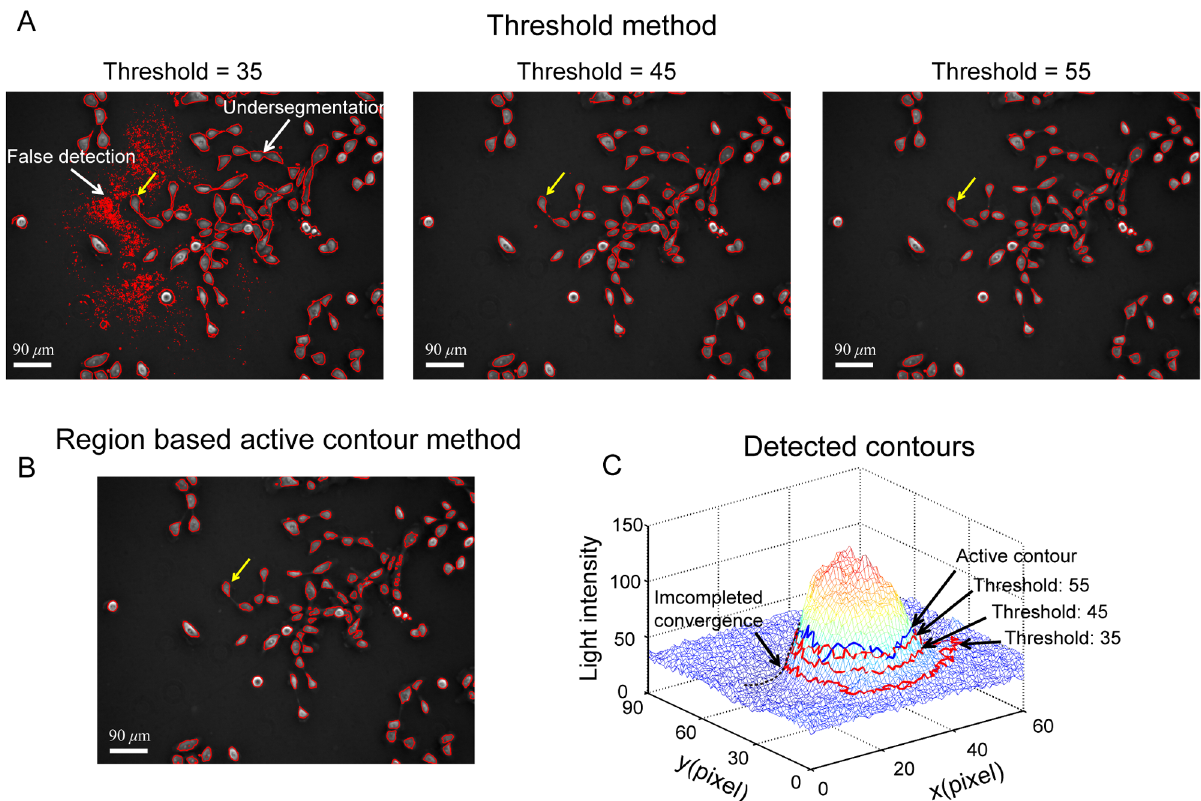
Fig 2. Cell image segmentation result obtained with different methods. (A) In the thresholding method, the segmentation result is sensitive to the selection of the threshold value. The detected contours shrink with increasing threshold value. (B) Cell image segmentation with the region based active contour method. (C) Comparison of the contours obtained with the region based active contour method and the thresholding method with different threshold values. It is apparent that both methods underestimate cell actual boundary.